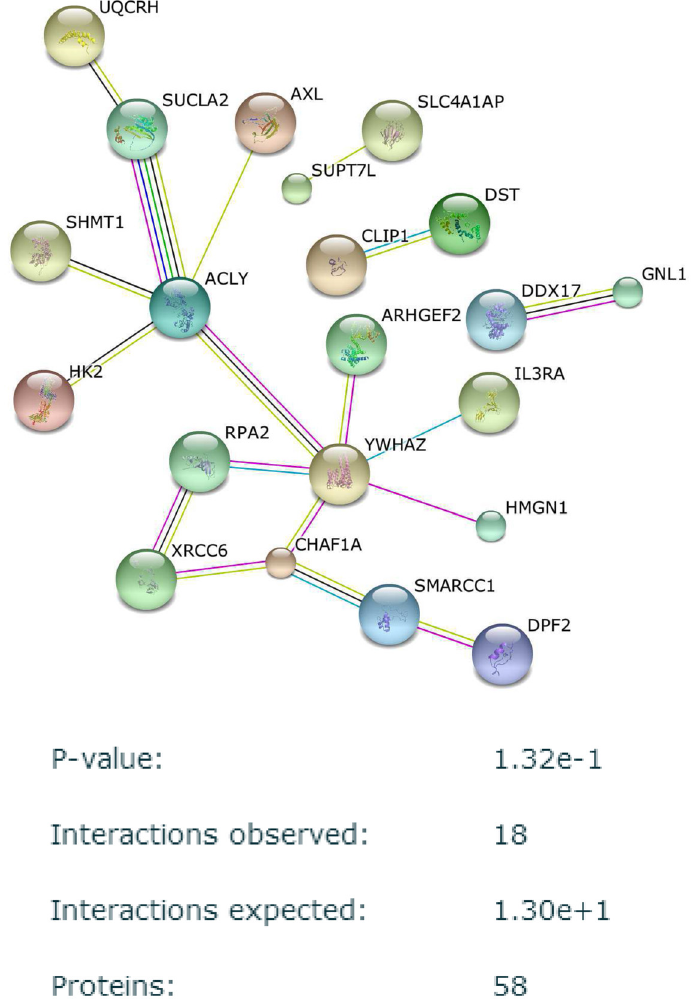
Fig 10. Protein-protein interaction network observed between top regulators found from VMRF in GDSC dataset S C 1 . Disconnected nodes are